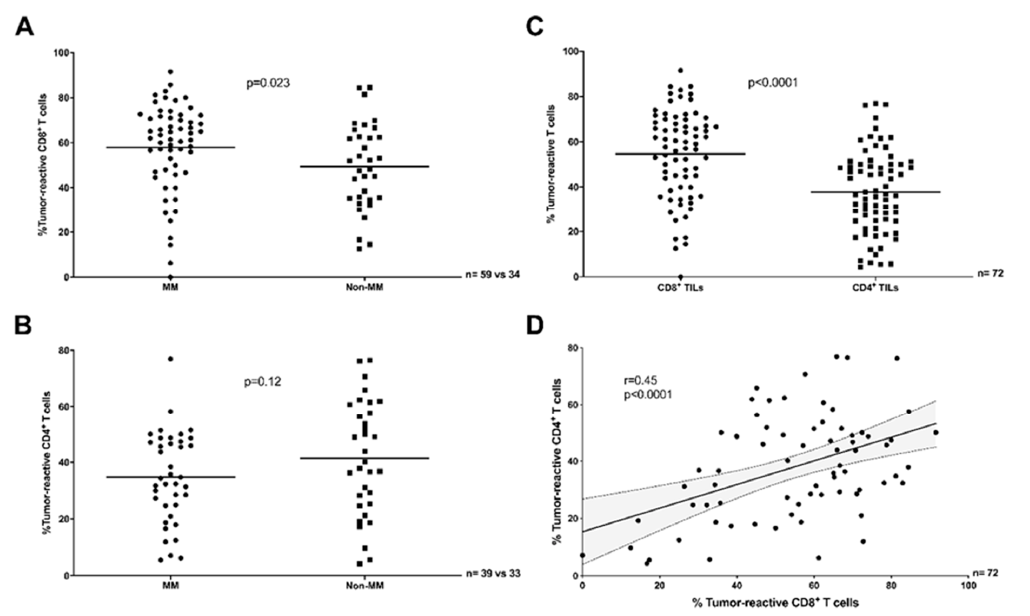
Figure 2. Antitumor-reactivity of TILs across clinical datasets and TIL sub-populations (scRNAseq in situ). ( A ) The proportion of tumor-reactive CD8 + TILs was greater in MM (PD-1 naïve plus PD-1 res) compared to non-MM (Mann–Whitney test, p = 0.023). ( B ) The proportion of tumor-reactive CD4 + TILs was comparable in MM (PD-1 naïve only) and non-MM (Unpaired t test, p = 0.12). ( C ) A greater proportion of CD8 + TILs were tumor-reactive compared to CD4 + TILs (Paired t test, p < 0.0001, MM PD-1 naïve plus non-MM). ( D ) The proportion of tumor-reactive CD8 + TILs was only moderately correlated to the proportion of tumor-reactive CD4 + TILs in the same samples (Pearson r = 0.45, p < 0.0001, MM PD-1 naïve plus non-MM). The solid line and dotted lines represent the best-fit regression line and 95% confidence interval, respectively. (A–D) T cells were considered reactive if positive for the expression of least one of TNF , IFNG , or TNFRSF9 .